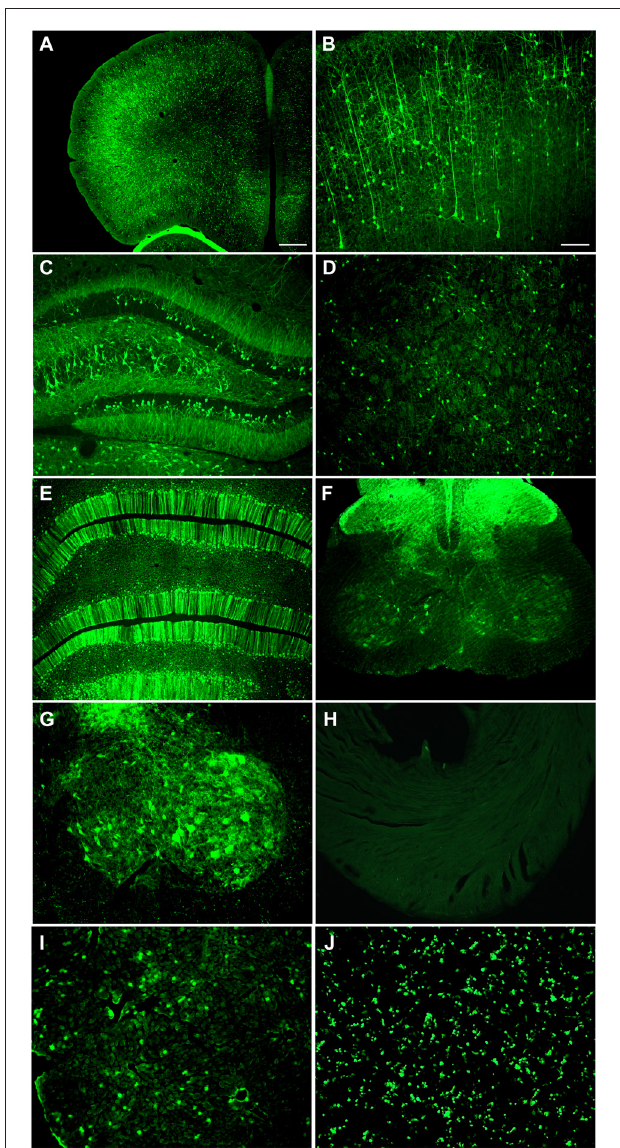
FIGURE 1 | Highly efficient wide-scale central nervous system (CNS) transgene expression in the rat using the synapsin promoter with avoidance of heart, but not liver expression. Synapsin promoter-AAV9 was administered intravenously to a neonatal rat and the tissue was analyzed 4 weeks later. (A,B) Expression in cortical neurons. (C) Hippocampus. (D) Striatum. (E) Cerebellum. (F,G) Spinal cord. (H) The heart had trace to no expression. (I) The synapsin promoter-AAV9 did result in expression in the liver. (J) This synapsin promoter DNA construct also drives expression in non-neuronal cells (HEK 293T) after transfection. Green fluorescent protein (GFP) immunostaining in (A–I) Native fluorescence in (J) Bar in (A) = 268 µ m, same magnification in (E,F,H–J) Bar in (B) = 134 µ m, same magnification in (C,D,G–I) .